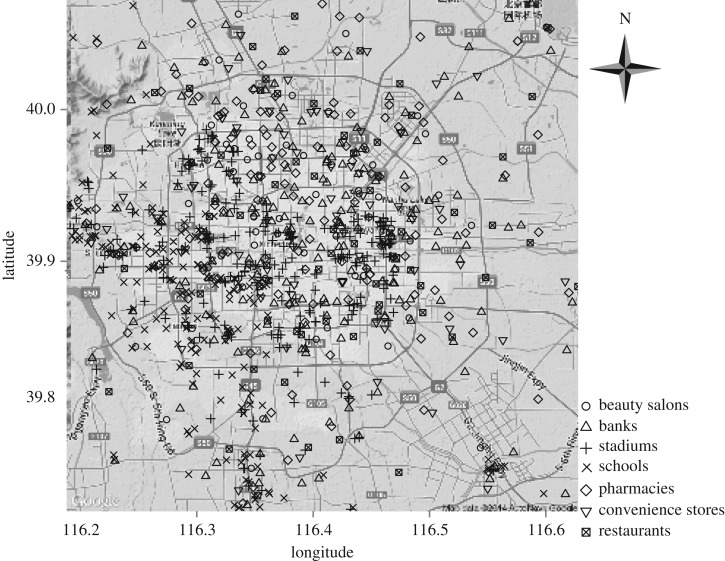
The distribution of seven types of facilities in Beijing. Three hundred random samples are marked in the map for illustrative purposes.